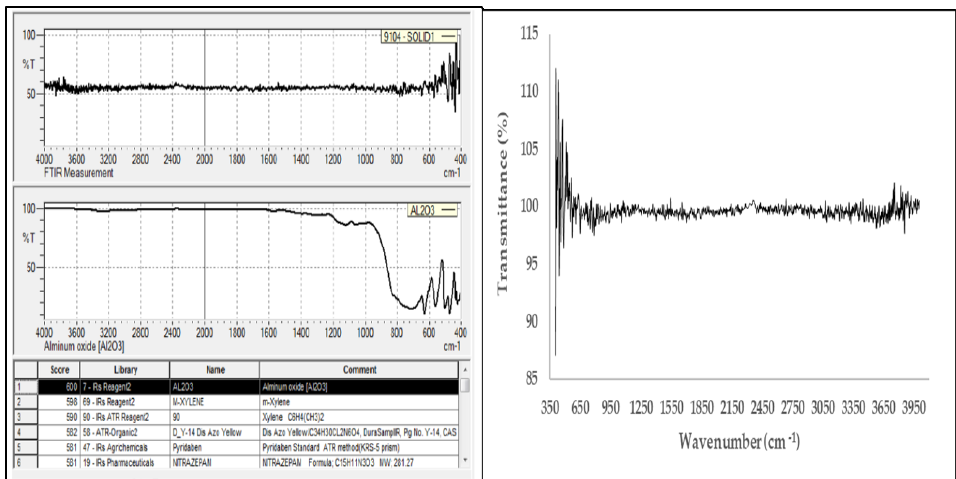
Figure 26. Fourier-transform infrared spectroscopy of sustainable red mud bricks.